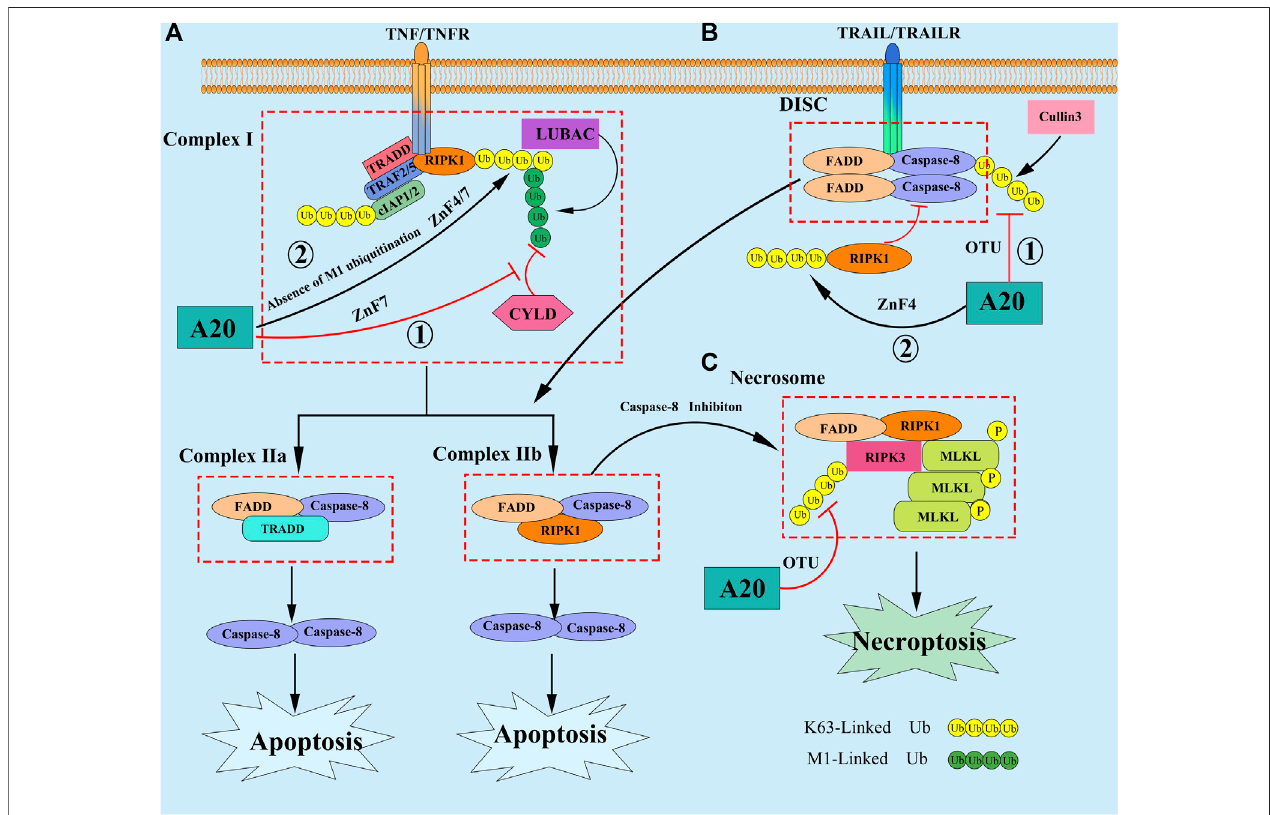
FIGURE 2 | (A) In response to TNF stimulation, A20 is reported to inhibit apoptosis by the following mechanisms: ① A20 was shown to be recruited to the membrane-bound complex I, and bound to M1-Linked polyubiquitin chains of RIPK1 via its ZnF7 domain, thereby protecting the M1-Linked polyubiquitin chains from CYLD-mediatedcleavageandrepressingthecomplexItransitioningtoadeath-inducingcytosoliccomplexII; ② InabsenceofM1-Linkedpolyubiquitinchains,theZnF4 andZnF7domainsofA20cooperatetobindtoothertypesofubiquitinchainsassociatedtoComplexI,potentiallyK63-Linkedpolyubiquitinchains,thenprotecting cells from apoptosis. (B) A20 can also inhibt apoptosis in the TRAIL signaling by the following mechanisms: ① A20 promote the formation of the K63-Linked polyubiquitin chains on RIPK1 through its ZnF4 domain, then RIPK1 being recruited to DISC, and inhibit the dimerization, cleavage of Caspase 8; ② A20 hydrolyze the cullin3-mediated K63-Linked polyubiquitin chains of Caspase-8, then inhibiting caspase-8 activation. (C) When Caspase 8 is inhibited, necroptosis can be triggered by DRs, which promote the recruitment ofRIPK3 and MLKL toRIPK1 forming Necrosome.Subsequently, RIPK3 can phosphorylate MLKL, resulting in ittranslocate to the plasma membrane to assemble a pore-forming complex, promoting the release of DAMPs into the environment, thereby inducing necrptosis. A20 restrict the K63- Linked polyubiquitin chains of RIPK3 through its OTU domain, preventing the formation of Necrosome and inhibiting necroptosis.